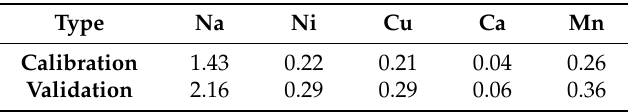
Table 4. The RMSEV of the PLSR